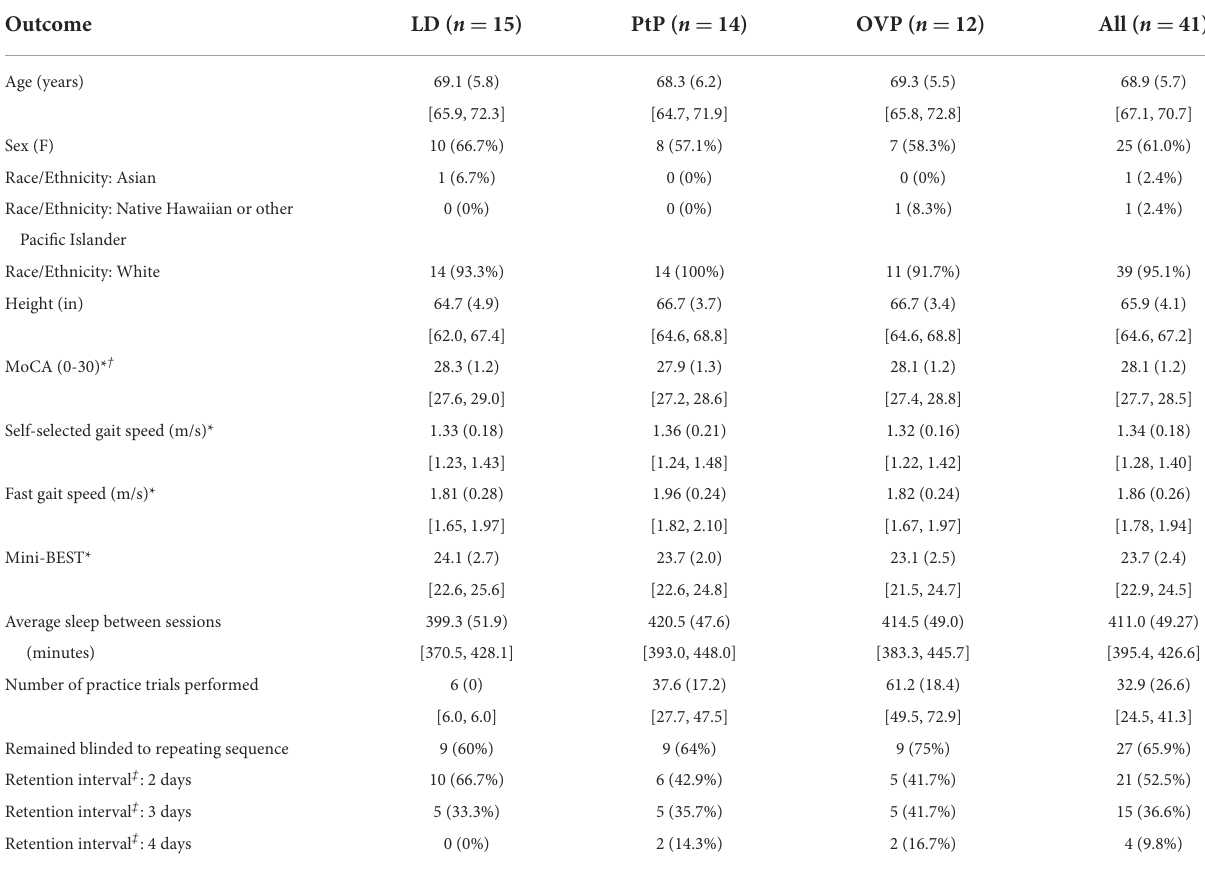
TABLE 1 Participant characteristics by